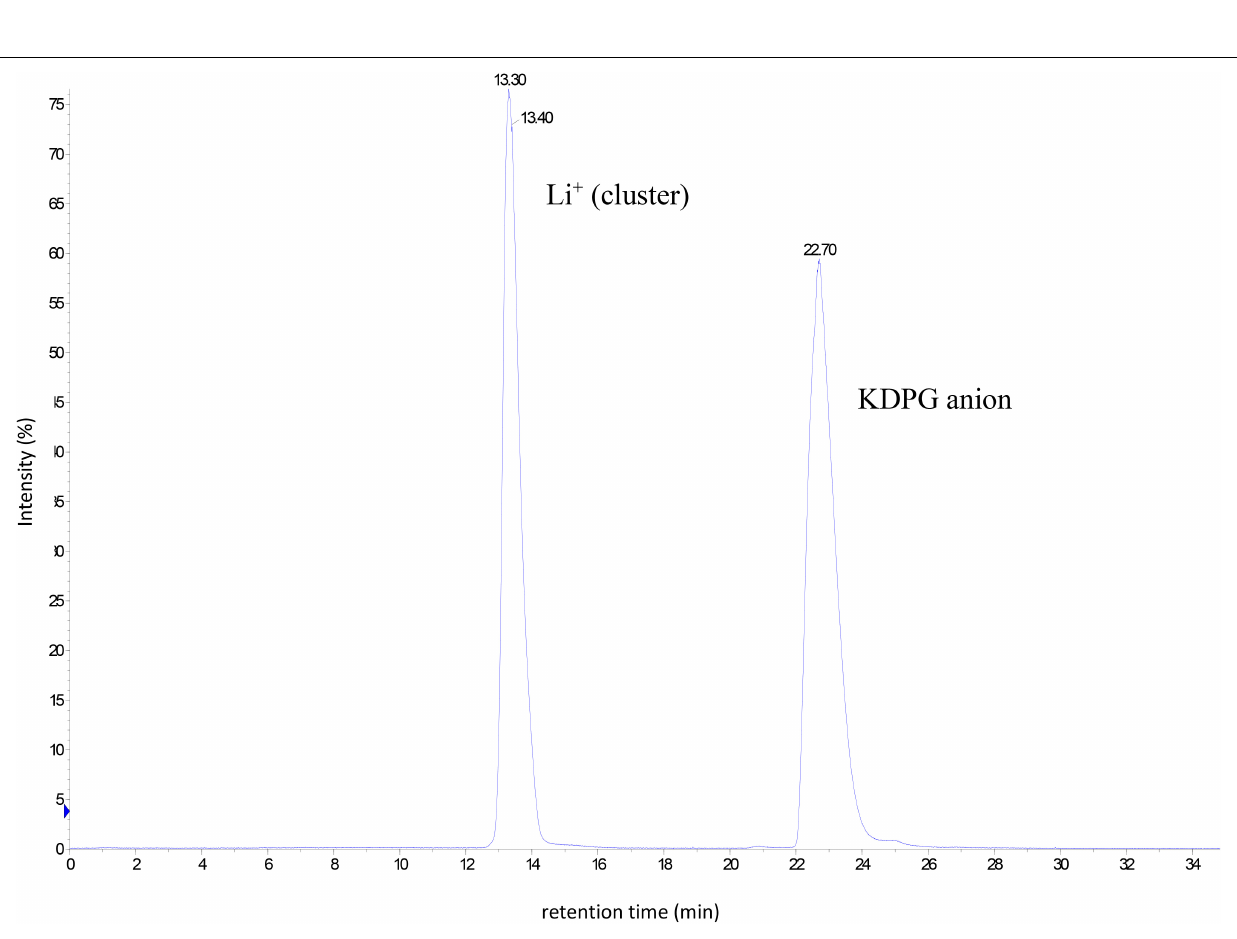
Frontiers in Bioengineering and Biotechnology |